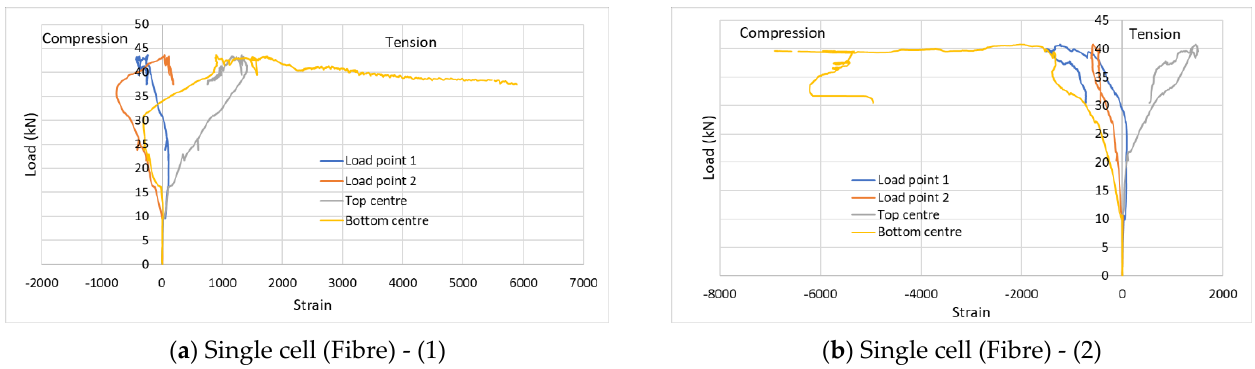
Figure 11. Strain mapping of single-cell panels with chopped basalt fibres.